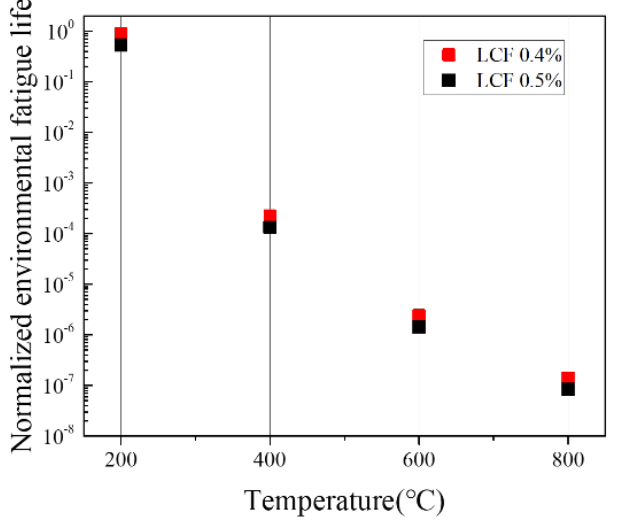
Figure 9. Normalized environmental fatigue life results calculated with Neu-Sehitoglu oxidation damage model.